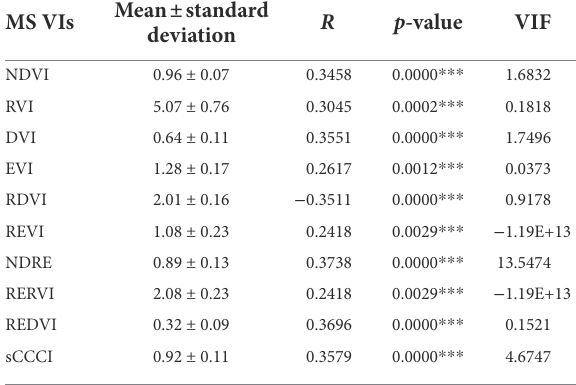
TABLE 5 VIF and correlation with SPAD in MS